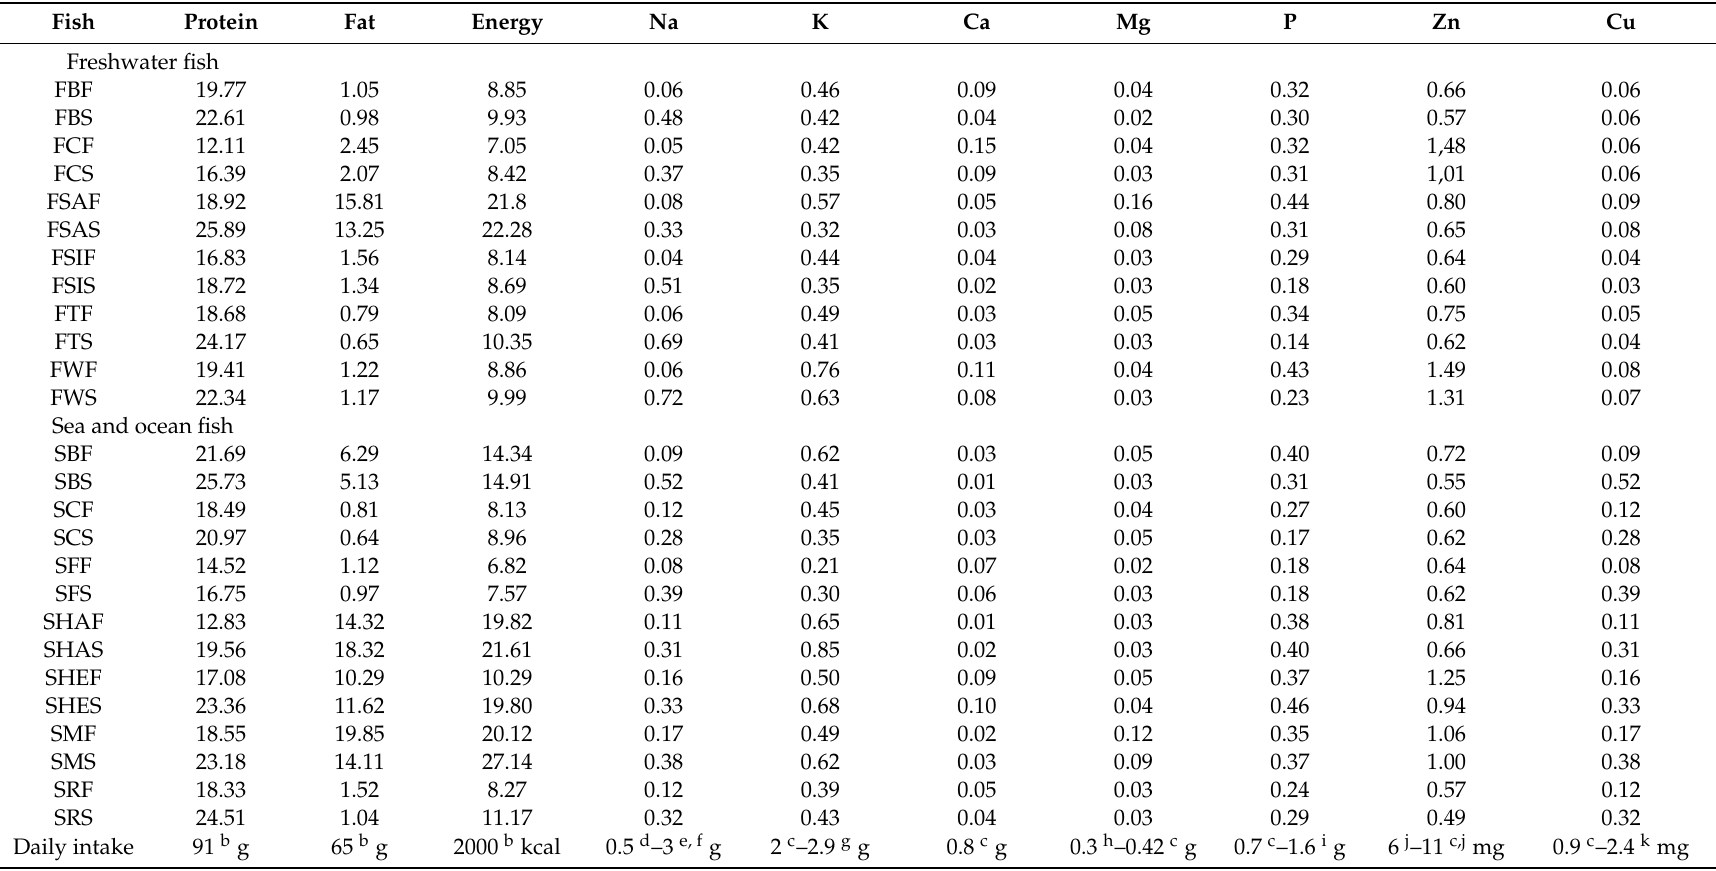
Table 4. Calculated percent coverage of daily supply for selected nutrients and macro and microelements by consuming one serving a of fresh and smoked fish. Fish Protein Fat Energy Na K Ca Mg Cu Freshwater fish